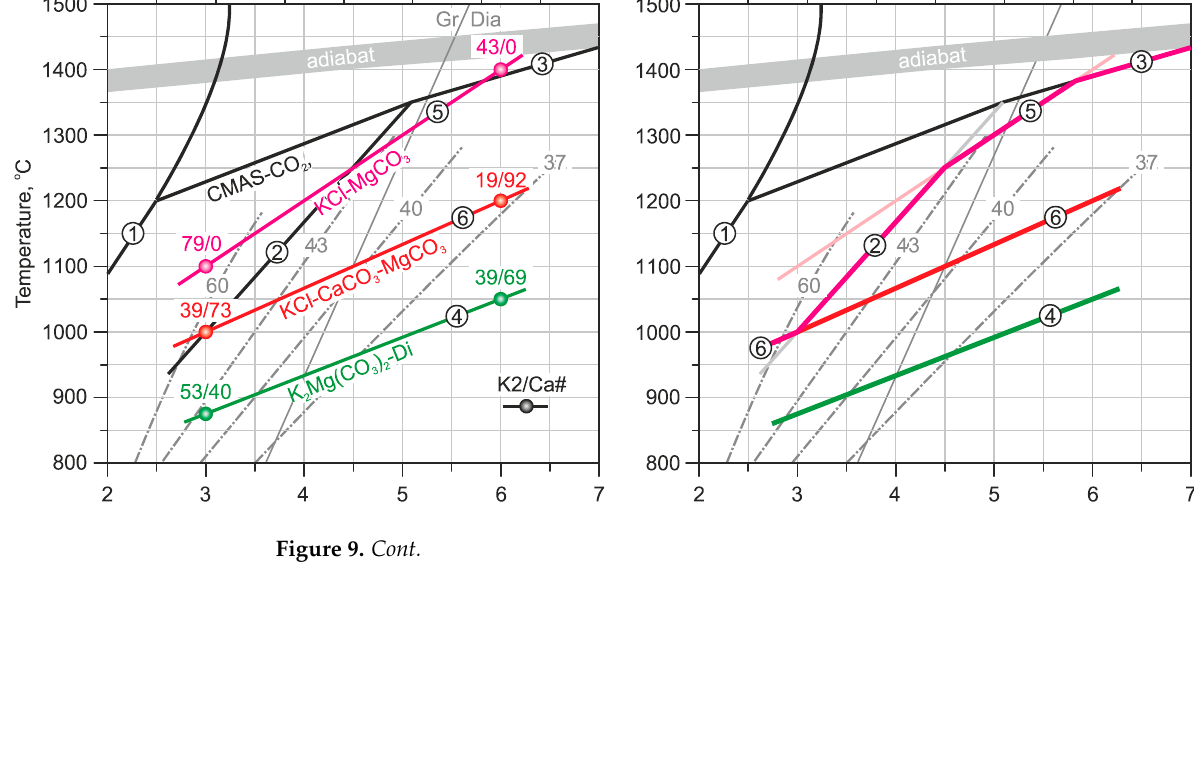
Figure 9. Solidi of K-, Cl-, and CO 2 -bearing systems: ( a ) the systems KCl+MgCO 3 , KCl+CaCO 3 +MgCO 3 , and diopside-K 2 Mg(CO 3 ) 2 ; ( b ) expected solidi of the peridotite-KCl-MgCO 3 system (magenta) and peridotite-K 2 Mg(CO 3 ) 2 system (green); ( c ) the systems carbonated phlogopite lherzolite (light blue), carbonated phlogopite eclogite (violet), diopside-K 2 Mg(CO 3 ) 2 (green); ( d ) comparison of solidi of peridotite containing KCl+Mgs (magenta), Phl+Mgs (light blue), and K 2 Mg(CO 3 ) 2 (green), and eclogite containing KCl+Dol (red), and Phl+Dol (violet). Dashed-dotted lines denote continental geotherms with the surface heat flow of 37, 40, 43 mW/m 2 [61]. ‘adiabat’— mantle adiabat is after [62]. (1)—[63,64], (2)—[65], (3)—[66], (4)—[67], (5), (6)—[32] and this study, (7)—[68], (8)—[69].